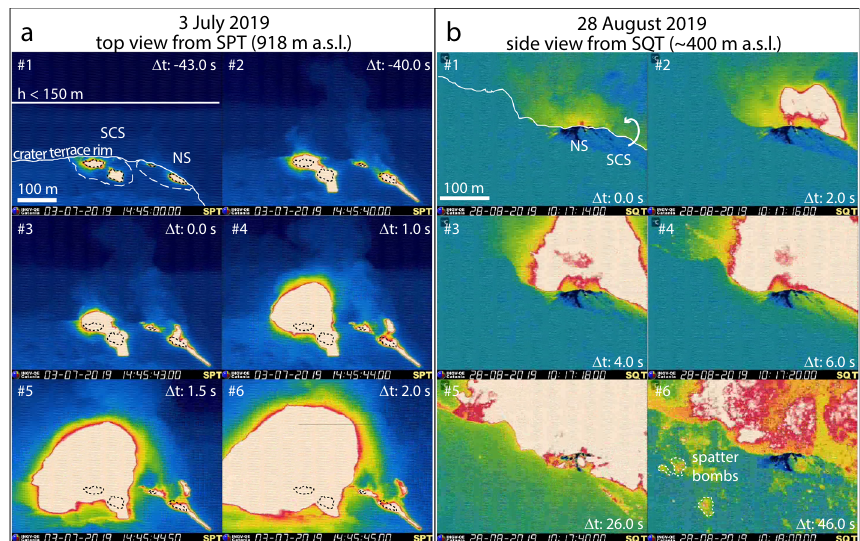
Fig. 2 Thermal image sequences of the two paroxysms. Δ t indicates time difference from explosion onset. a 3 July paroxysm (from SPT camera): #1 – #2 fast out fl owing of lava occurs simultaneously at the North Sector (NS) and South-Central Sector (SCS), respectively, ~43 s before the paroxysm; #3 – #6) explosion onset (at 14:45:43) and radial expansion of the incandescent jet in the following 2 s (14:45:45). For reference, the maximum elevation for ‘ normal ’ explosions is reported in #1. b 28 August paroxysm (from SQT camera): #1 – #5 the progression of the initial blast between 1 s and 26 s after the explosion onset; #6) the fl ank of Stromboli covered by ‘ spatter ’ bombs (i.e., fl uidal fragments of magma, dashed white lines) 46 s after the